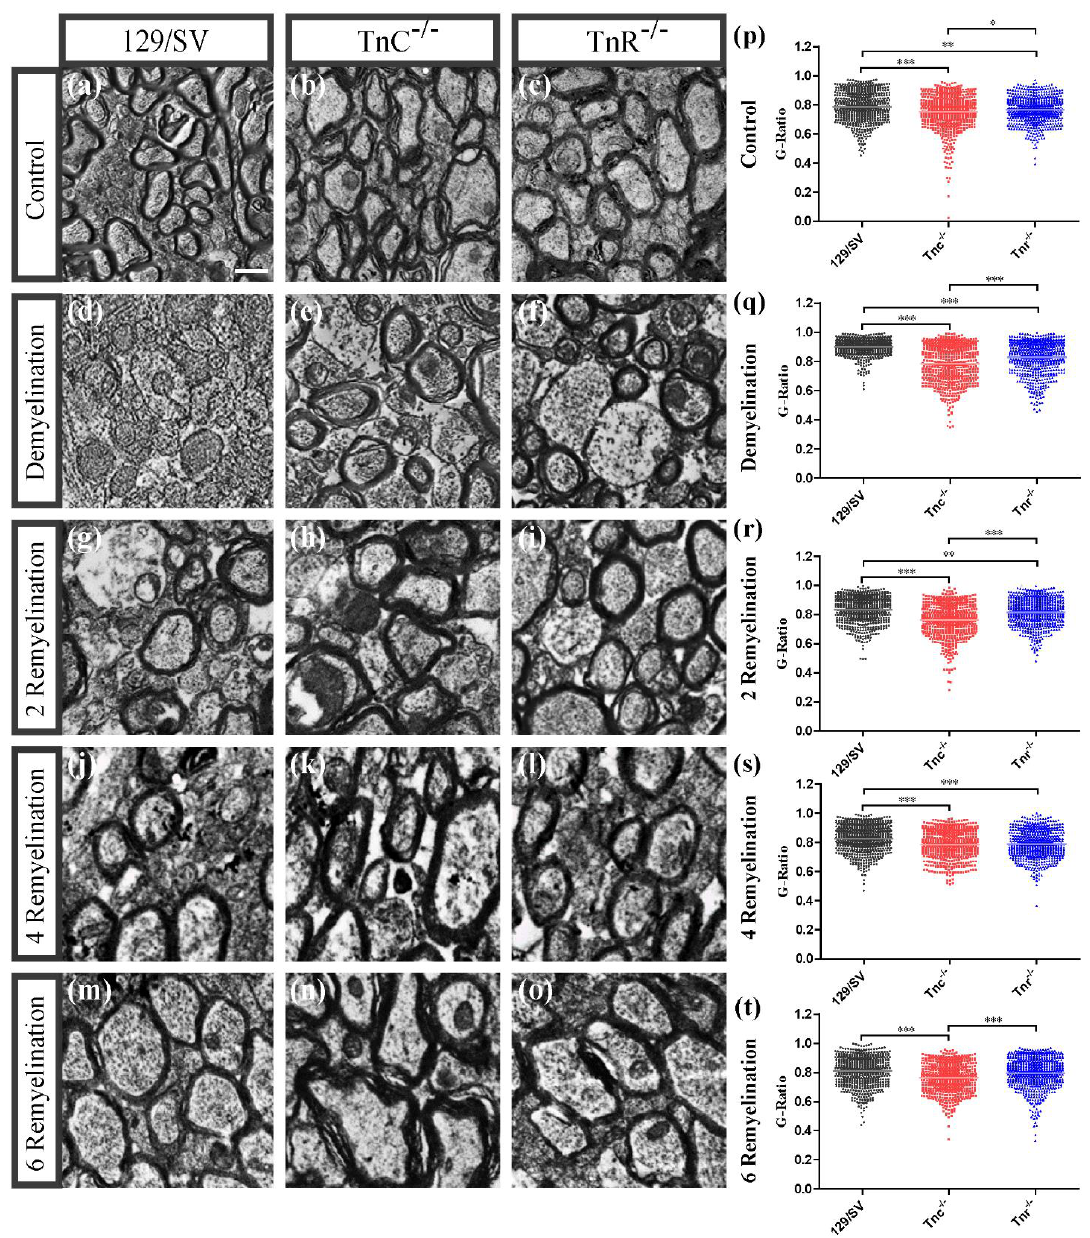
Figure 3. Electron microscopy reveals increased remyelination in Tnc − / − and Tnr − / − mice. Eight-to- ten-week-old male mice received either a normal diet as untreated control or a 0.2% cuprizone diet to induce demyelination ( a – t ). After 10 weeks mice were either perfused or received a normal diet for 2, 4, or 6 further weeks to allow for remyelination after withdrawal. Cryosections of the corpora callosa (CC) above the hippocampus as an orientation point (HC) from 129/SV, Tnc − / − and Tnr − / − brains were collected, processed for electron microscopy and the myelin thickness was determined ( a – t ). Scale bar: 1 µ m. The results confirmed the cuprizone-induced demyelination ( d – f ), although the demyelination in Tnc − / − and Tnr − / − mice appeared significantly weaker ( p ). In the untreated control condition ( a – c , p ) thicker myelin membranes were observable in Tnc − / − and Tnr − / − mice as indicated by g-ratios. Furthermore, Tnc − / − and Tnr − / − mice displayed more efficient remyelination at each timepoint ( g – o , r – t ). For statistical analysis, the unpaired two-tailed student’s test ( p ≤ 0.05 *, p ≤ 0.01 **, p ≤ 0.001 ***) was used. Axon diameters seemed smaller in Tnc − / − and Tnr − / − mice. Statistical comparison of the individual groups was carried out with the ANOVA test and Tuckey’s multiple comparison test. (N = 3, n ≤